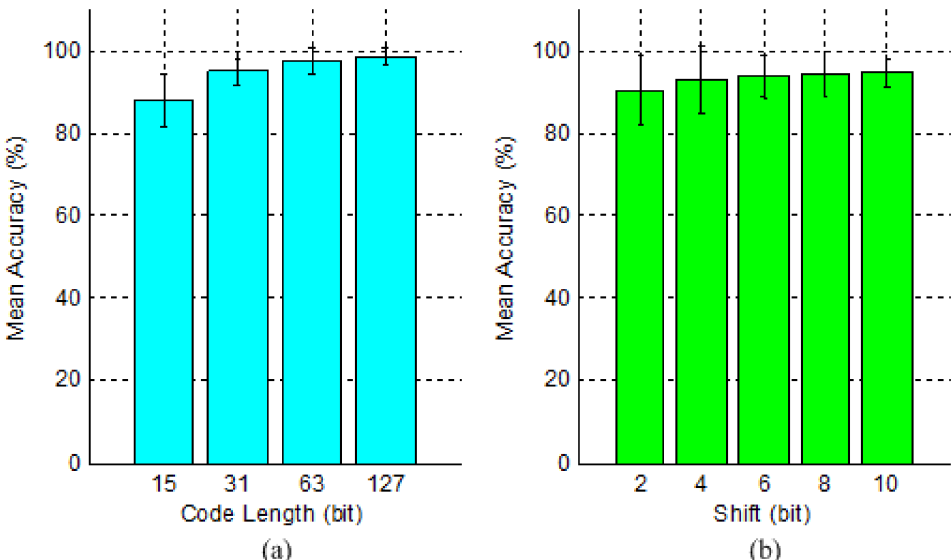
Fig 7. Average classification accuracy across subjects yielded by different lengths of M sequences (i.e. code lengths) (a) and different versions of shifts of the 63-bit M sequence between two adjacent targets (b).The error bars denote standard